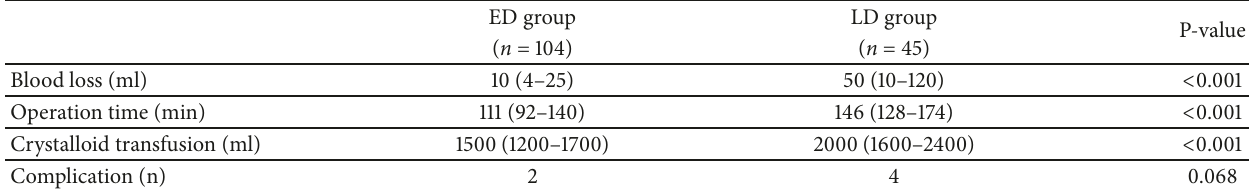
Table 2: Univariate analysis for perioperative factors.